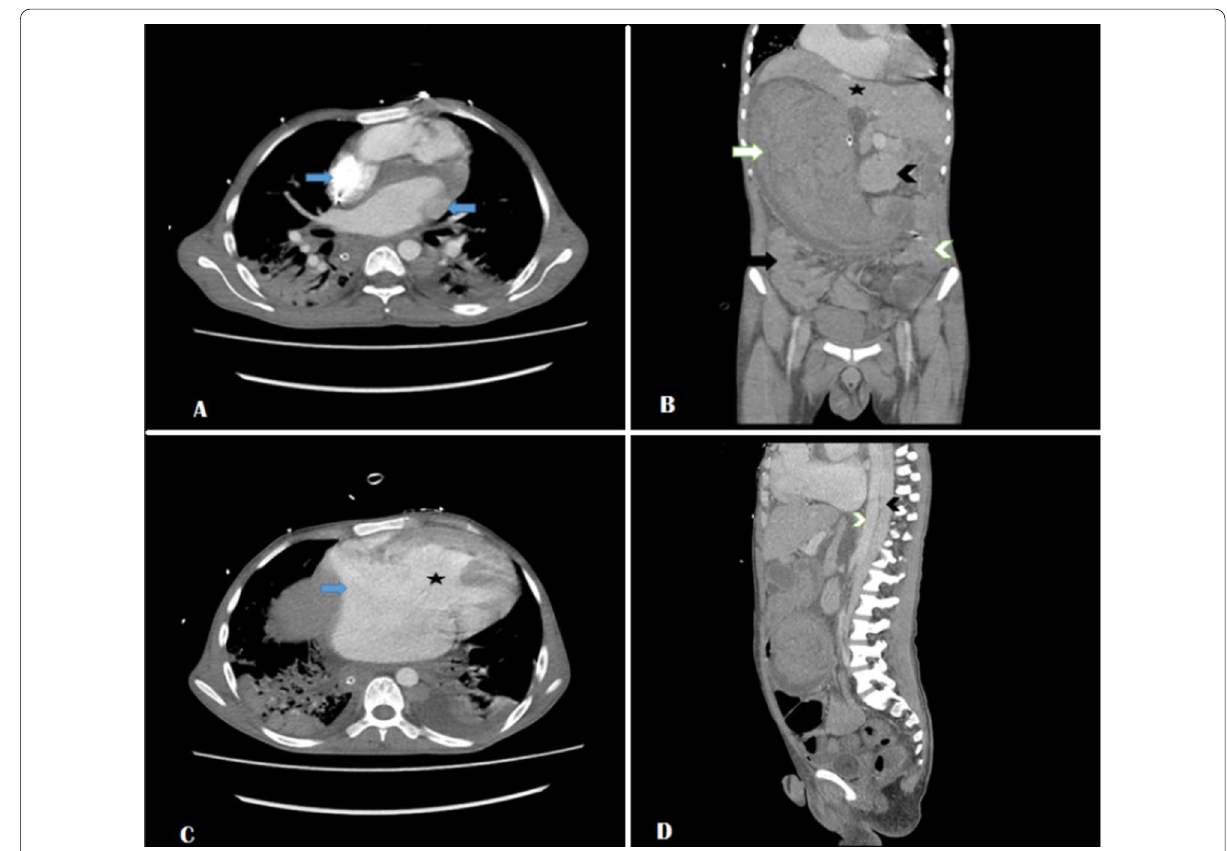
Fig. 1 Contrast-enhanced CT (CECT) showing features of heterotaxy syndrome. A Axial section of CECT showing double superior vena cava (SVC) (blue arrows). B Post-contrast, coronal section showing midline liver (black asterisk), stomach though distended with high-density content but seen on right side of midline (white arrow), head of pancreas on the left side of midline (black arrowhead), small bowel loops on the left side of midline (black arrow) and large bowel on right side of midline (white arrowhead). C Axial section showing large subvalvular ventricular septal defect (VSD) (black asterisk) and dilated right atrium. D Post-contrast Sagittal section showing anteriorly placed aorta (white arrowhead) and dilated azygous vein (black arrowhead). Azygous continuation of inferior vena cava can be seen below the level of the diaphragm